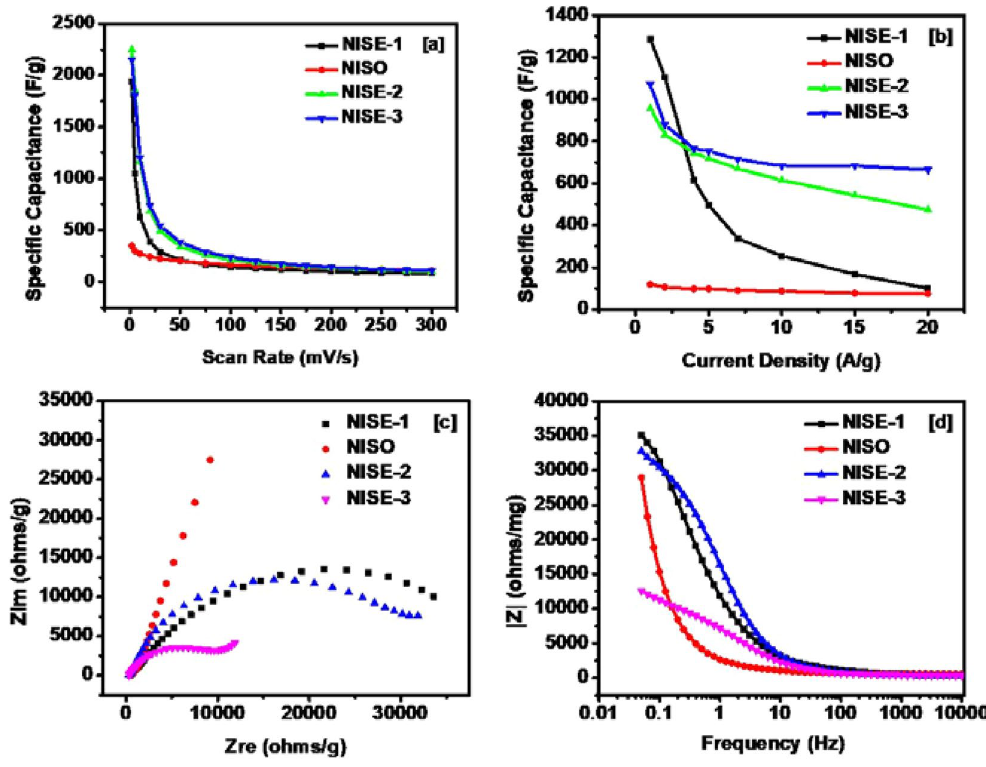
Figure 8. ( a ) Variation of specific capacitance versus scan rate for all synthesized samples, ( b ) Variation of specific capacitance versus applied current density for all synthesized samples, ( c ) Zre vs Zim plots of the devices, ( d ) Variation of impedance as a function of frequency for the devices.